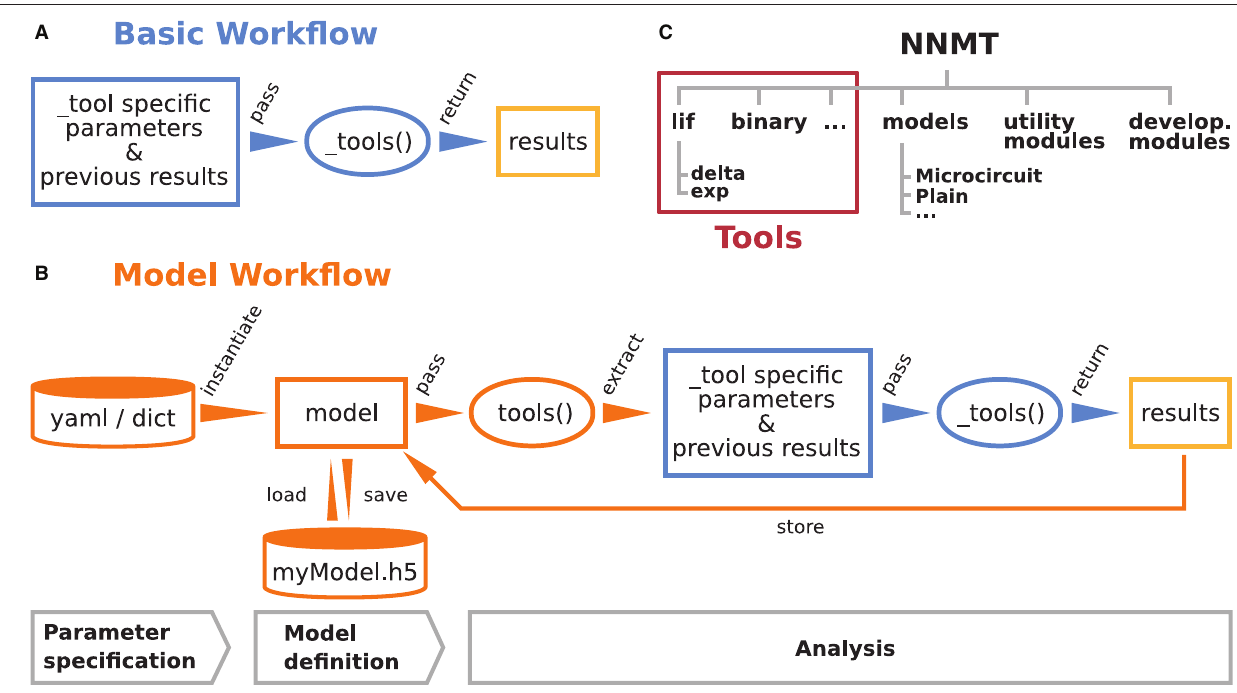
FIGURE 1 | Structure and workflows of the Neuronal Network Mean-field Toolbox (NNMT). (A) Basic workflow: individual mean-field based analysis methods are implemented as functions, called _tools() , that can be used directly by explicitly passing the required arguments. (B) Model workflow: to facilitate the handling of parameters and results, they can be stored in a model class instance, which can be passed to a tool() , which wraps the basic workflow of the respective _tool() . (C) Structure of the Python package. In addition to the tool collection (red frame), containing the tools() and the _tools() , and pre-defined model classes, the package provides utility functions for handling parameter files and unit conversions, as well as software aiding the implementation of new